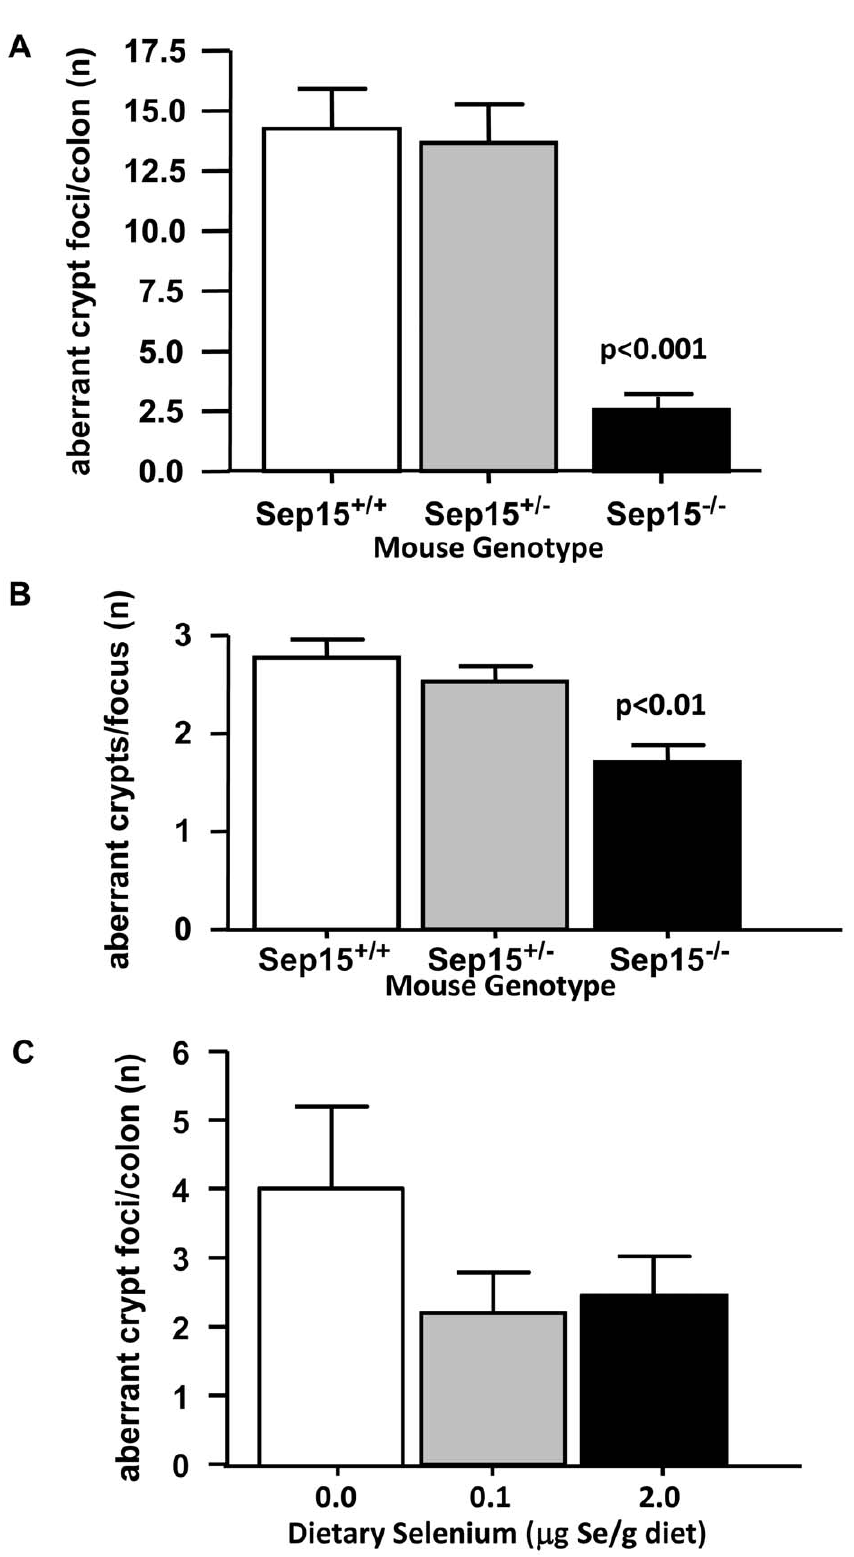
Figure 1. Aberrant crypt foci formation in AOM-treated wild type allelic (Sep15 + / + ), heterozygous (Sep15 + / 2 ) and Sep15 knockout (Sep15 2 / 2 ) mice. (A) Number of ACF per colon in mice fed 0.1 m g selenium/g diet (mean 6 SEM; N=12 per genotype); (B) number of aberrant crypts per focus in mice fed 0.1 m g selenium/g diet (mean 6 SEM; N=12 per genotype); (C) numbers of ACF in Sep15 knockout mice on 0, 0.1 or 2.0 m g selenium/g diet (mean 6 SEM, N=8–10).